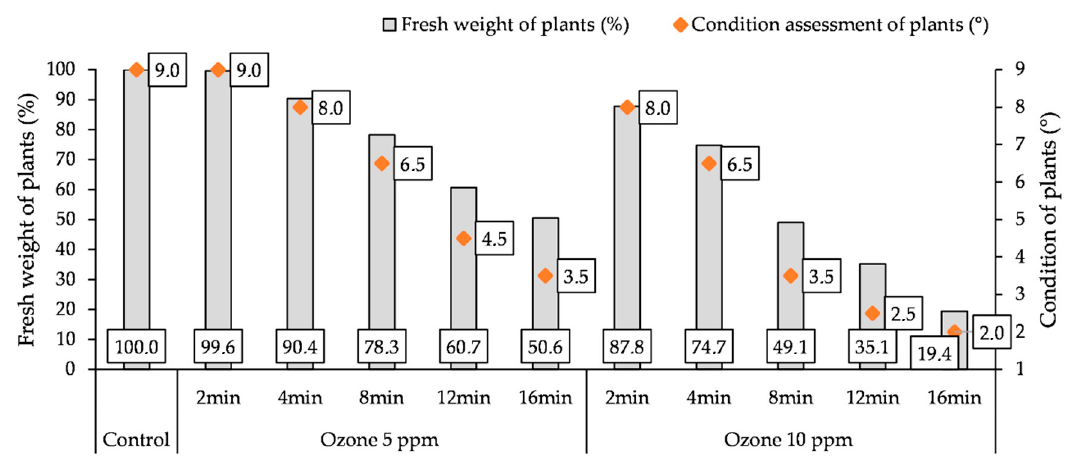
Figure 5. Changes in fresh weight (FW) of plants and condition assessment of plants (9—most favorable, 1—least favorable) at the end of the experiment (7th day after the 2nd O 3 fumigation), depending on O 3 concentration, exposure time, and measurement terms.